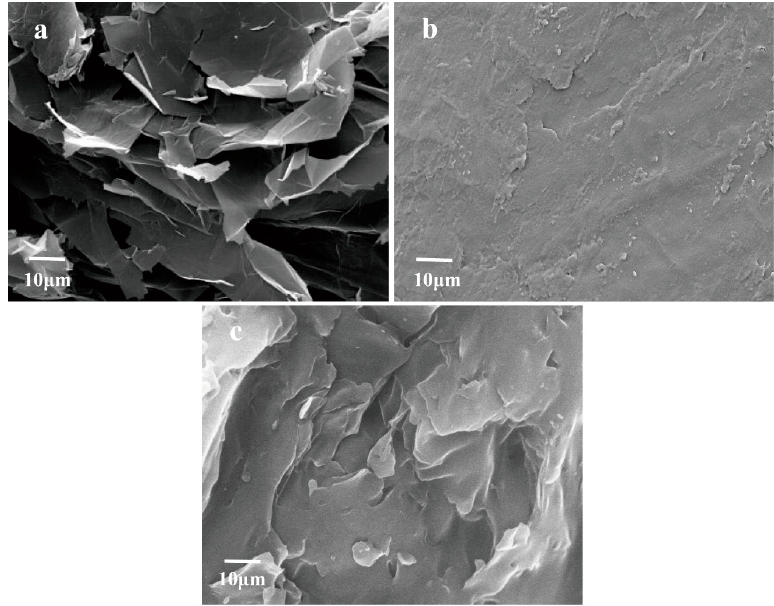
Figure 1. Scanning electron microscope (SEM) images of the graphene nanoplatelets (GNPs) ( a ), pristine polyethylene glycol (PEG) ( b ) and PEG/GNPs-2% composite ( c ).